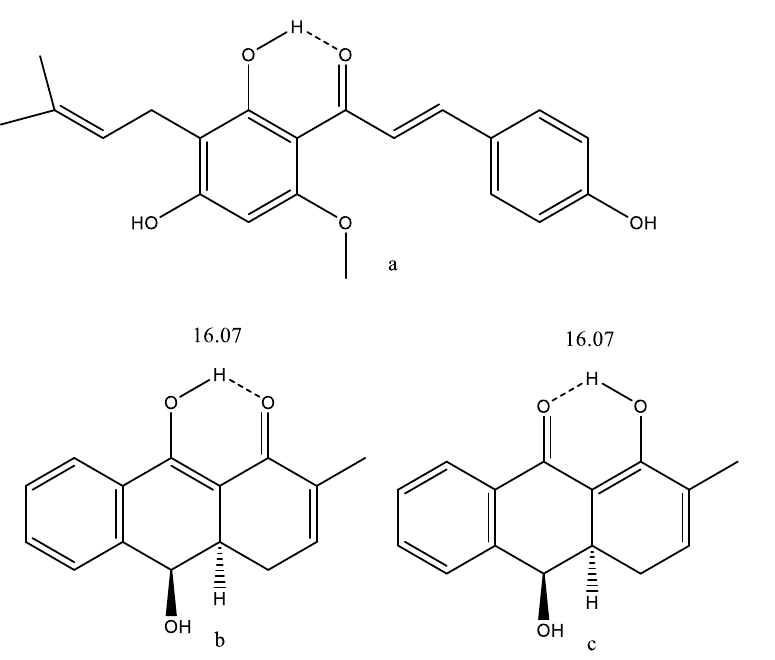
Figure 28. ( a ) A hydrogen bonded version of xanthohumol. ( b ) and ( c ) tautomeric forms ofDihydroanthracen-1(4 H )one.